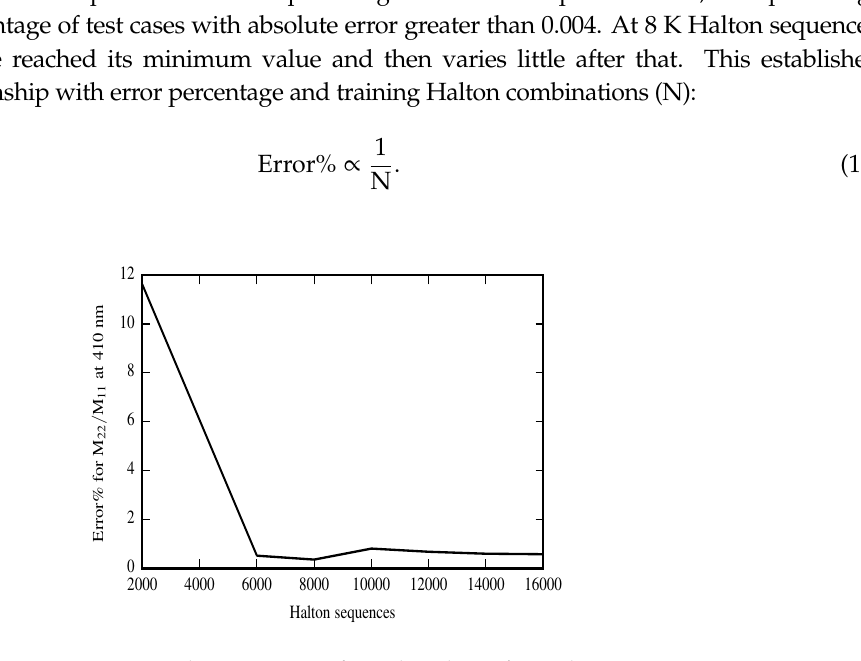
Figure 3. Error% versus Halton sequences for reduced M 22 /M 11 element at 410